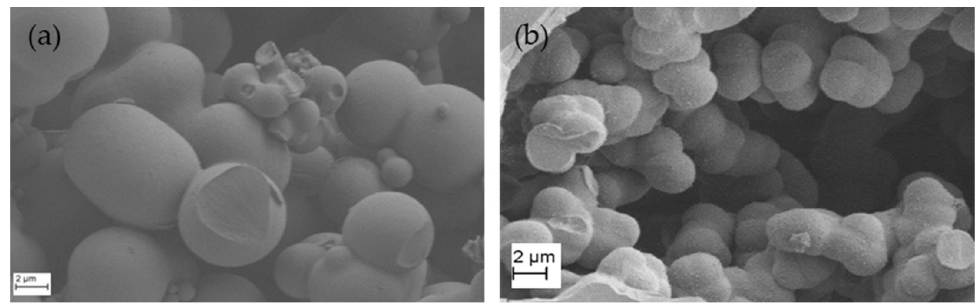
Figure 2. SEM micrograph of ( a ) untreated RF xerogel and ( b ) RF xerogel silylated with TBSCl.